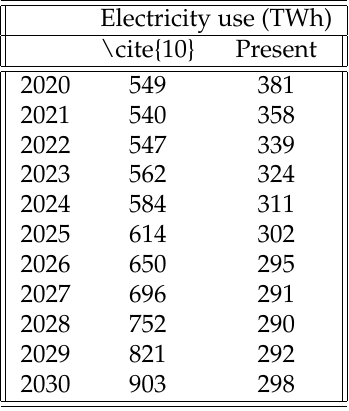
Table 6. Differences between [3] expected case and the present prediction for production of ICT hardware.